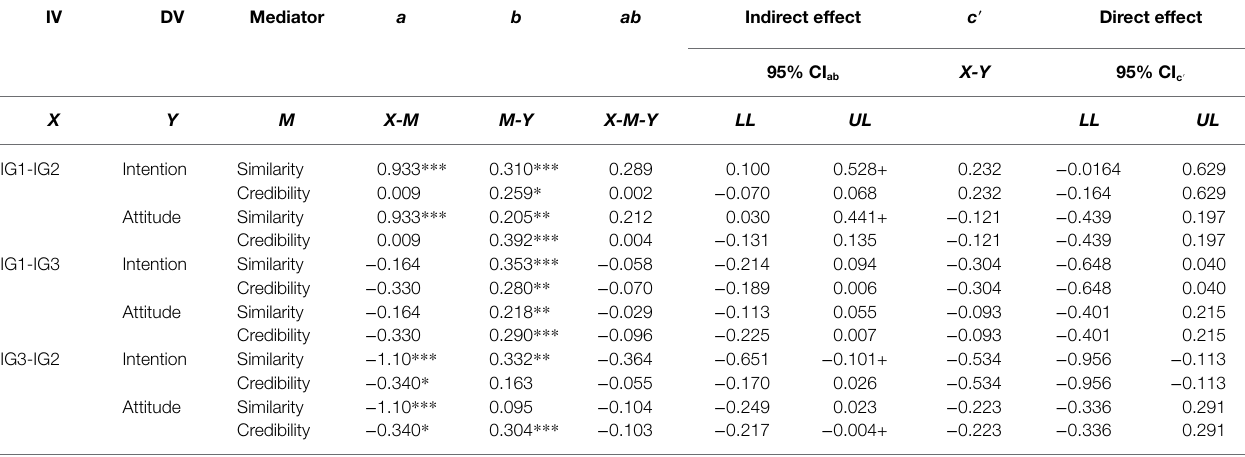
TABLE 3 | Mediation analyses on the influence of narrative intervention type on acceptance.